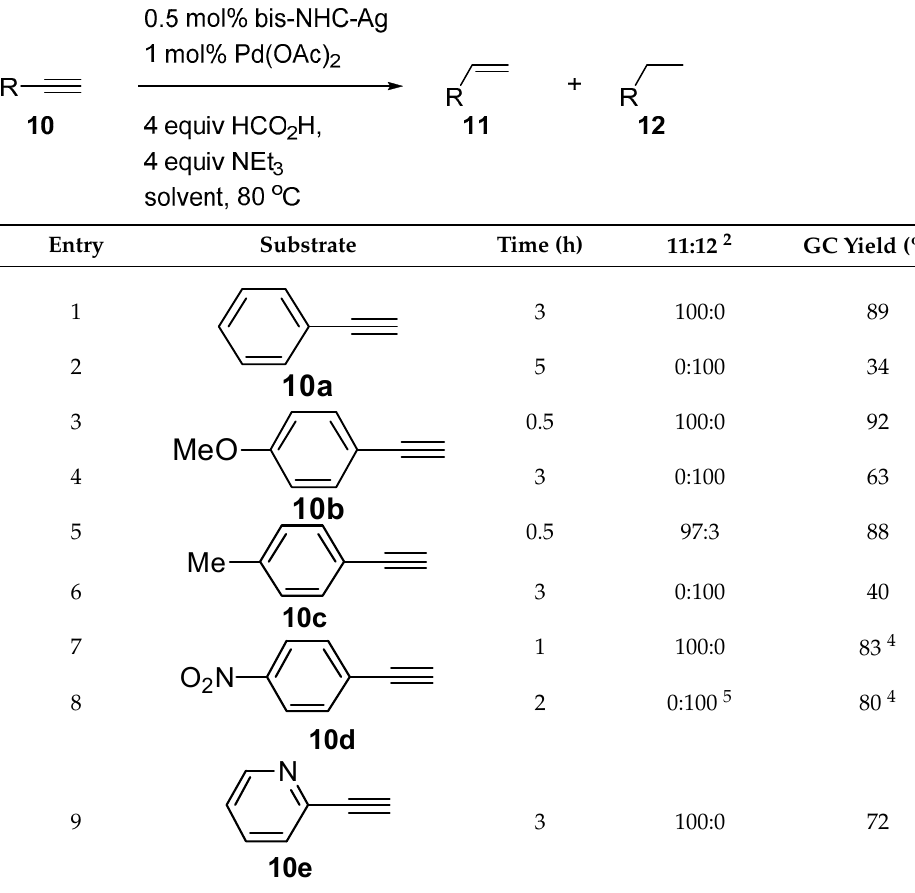
Table 5. Chemoselectivity studies for bis -NHC–Ag / Pd(OAc) 2 catalytic system catalyzed transfer hydrogenation of terminal alkynes in aqueous media 1 .